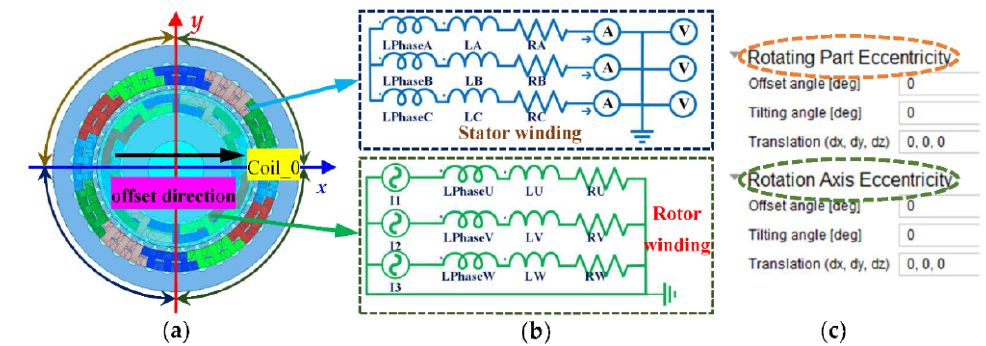
Figure 3. FEA setup: ( a ) three-dimensional models of DFIG; ( b ) external circuit; and ( c ) eccentricity setting interface.